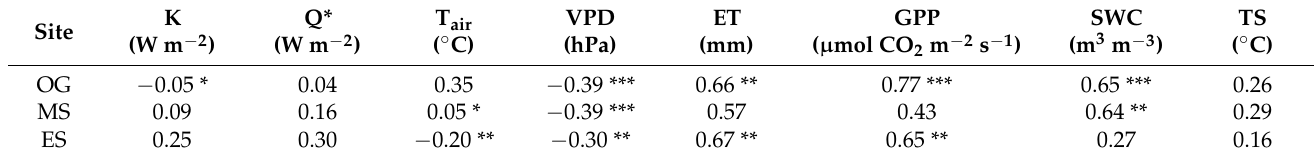
Table 6. Correlation coefficients of soil respiration with global radiation (K), net radiation (Q*), air temperature (T air ), vapor deficit pressure (VPD), evapotranspiration (ET), gross primary production (GPP), soil volumetric water content (SWC) and soil temperature (TS) in old-growth (OG), mid- secondary (MS) and early-secondary (ES) tropical dry forests in northwestern Mexico. The “*”, “**” and “***” represent the 0.0001, 0.001 and 0.05 significance probability of p -value,